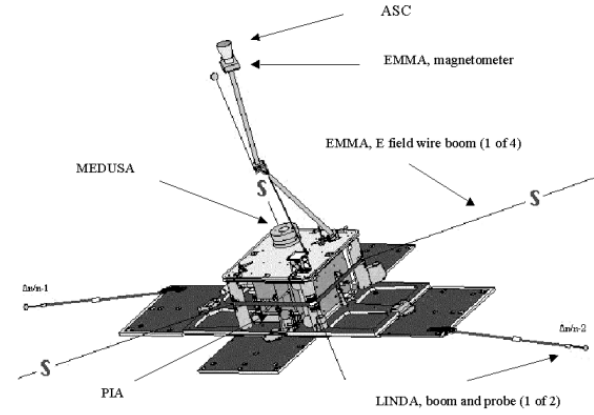
Fig. 2. The Astrid-2 scientific